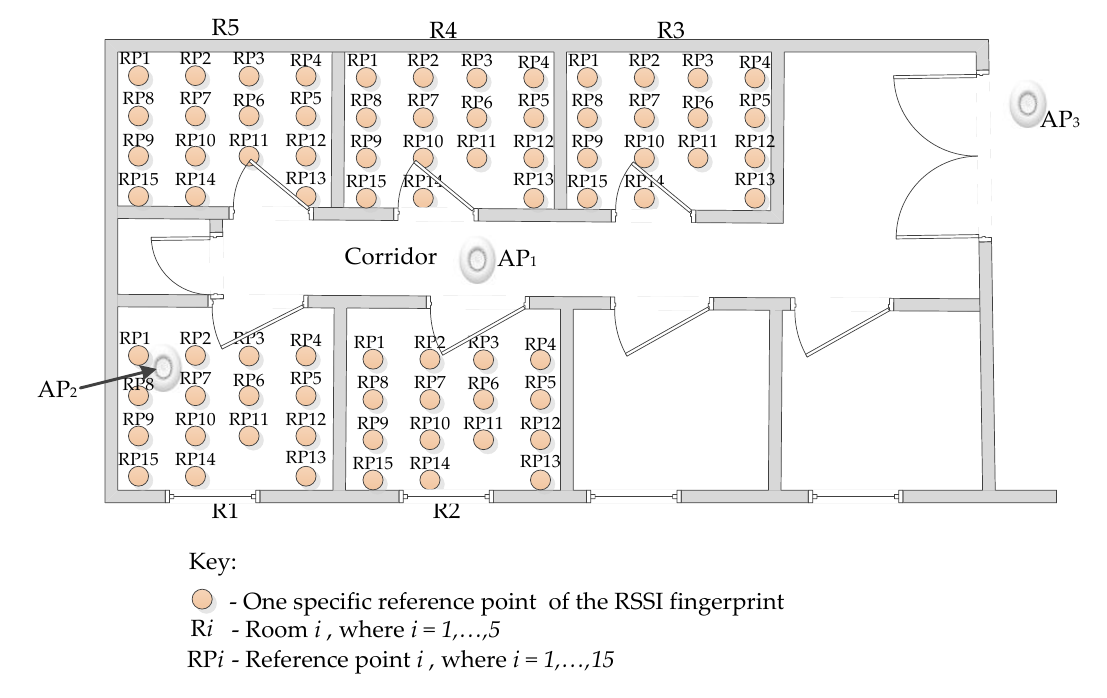
Figure 5. Fingerprint data collection scenario. Table 2. Dataset sizes.